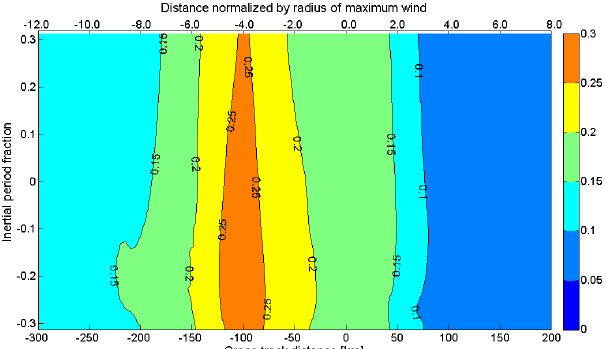
Figure 14. The HJ SST anomaly with respect to the total HHJ run anomaly (see Eq. 1). Here, distance perpendicular to the best track is plotted on the lower x axis; negative values are to the left of the track, and positive values are to the right of the track. The upper x axis presents the same distance but normalized by the radius of maximum wind, which is 25km in this case. On the y axis there is distance along the trajectory represented as time normalized by the inertial oscillation period (40h). The cross-track distance measures distance from the trajectory of typhoon Jangmi. The position of typhoon Hagupit is at − 140km. It can be seen that there is positive anomaly to the left and negative anomaly to the right of Jangmi’s track. Color scale represents temperature anomaly [ ◦C].